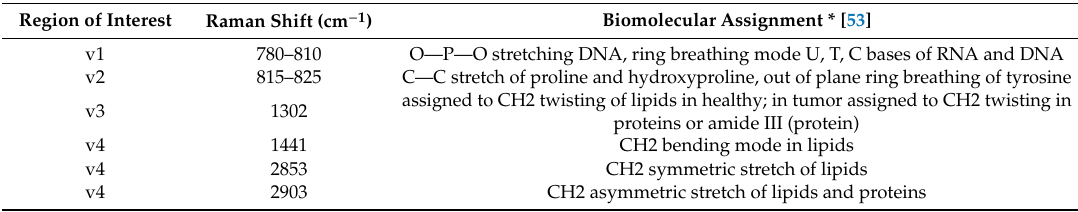
Table 1. Biomolecular assignments of six regions of interest in spectra displayed in Figure